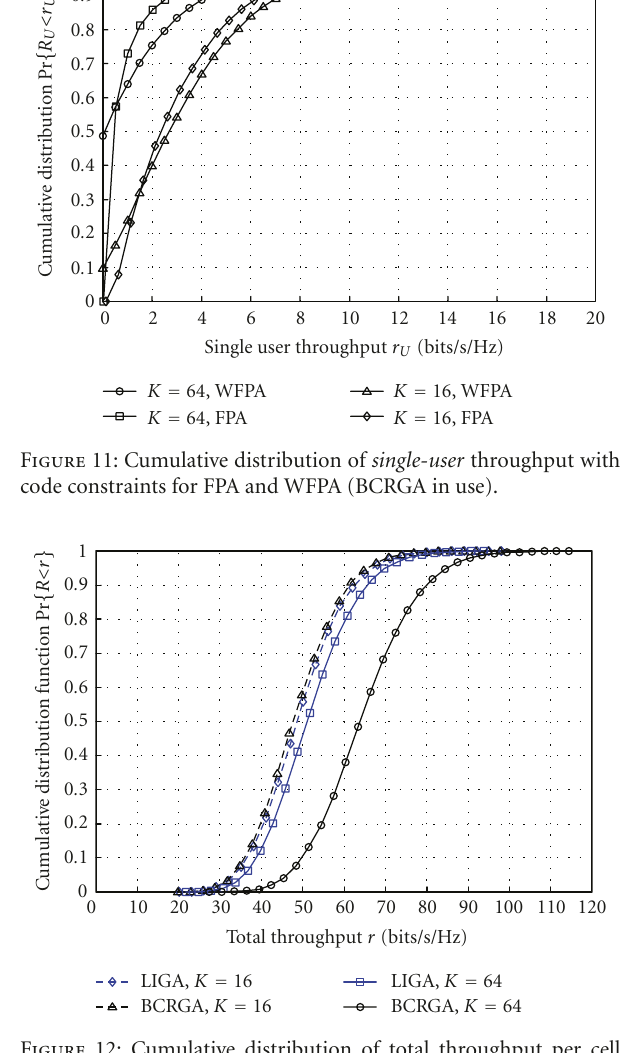
Figure 12: Cumulative distribution of total throughput per cell with code constraints for